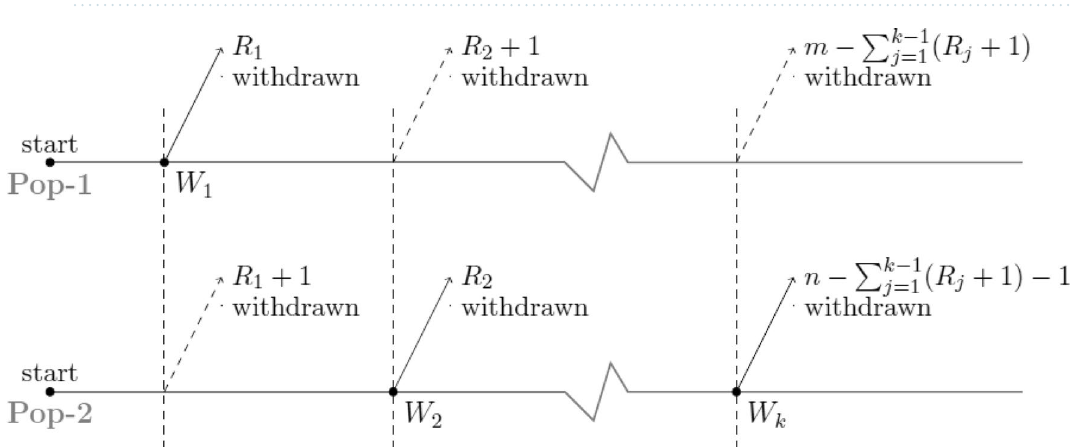
Figure 1. Case-I: kth failure comes from Pop-1.